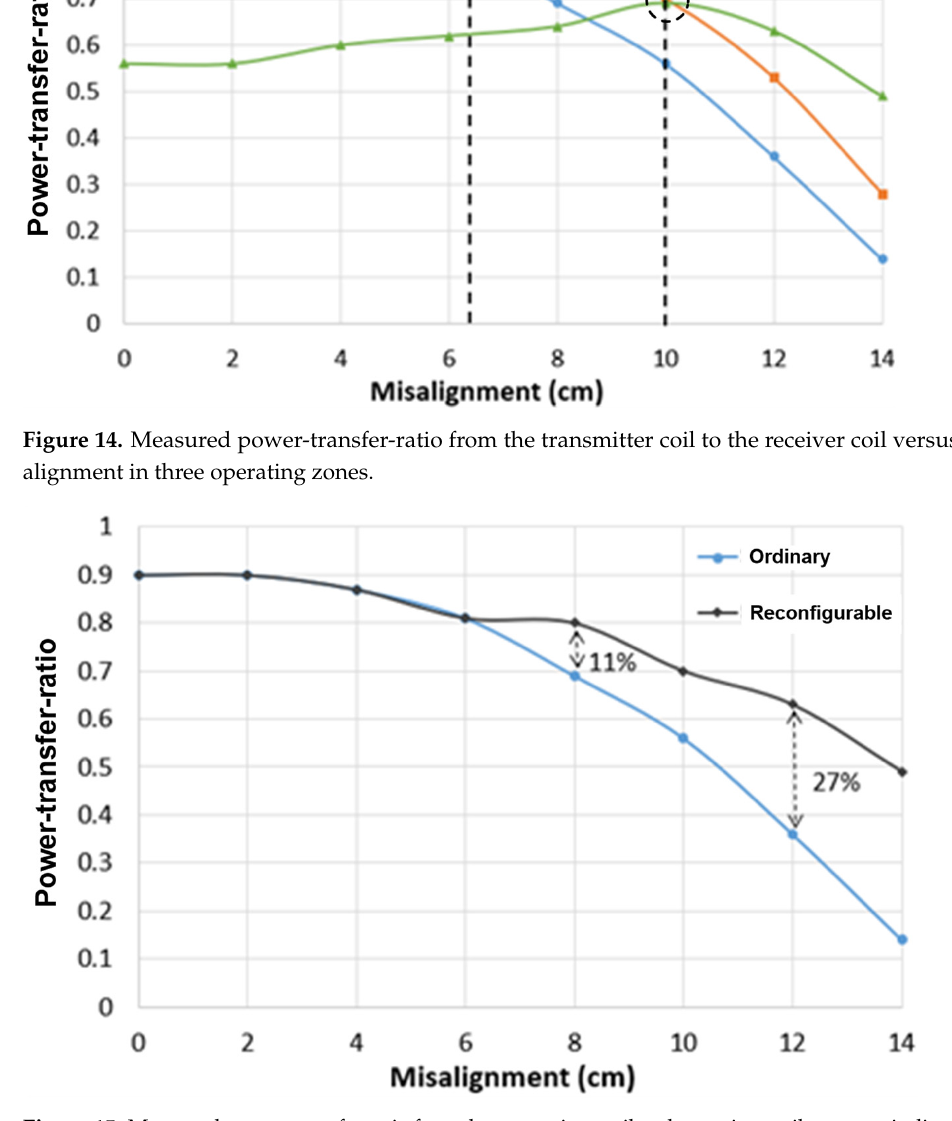
Figure 16. A 3D plot of measured power-transfer ratio from the transmitter coil to the receiver coil versus transmission distance and misalignment. 6. Conclusions With the use of a multi-tap transmitter coil and a zone impedance matching tech- nique, the power transfer capability of an inductive charging system is improved over a long distance. The proposed system adaptively performs impedance matching to cope with the change of transmission distance and misalignment. The input impedance of the transmitter coil is selected by switching different taps of the transmitter coil. The trans- mission power is significantly increased compared with the ordinary structure. The con- trol strategy uses the information from the transmitter to estimate the load position and select the proper turns of the transmitter coil. A proof-of-concept prototype was built to verify the proposed system and to evaluate the effectiveness of the control strategy. Ex- perimental results confirmed that the proposed system performs well in the case of trans- mission distance variation and misalignment tolerance. Increasing the number of taps in the transmitter coil will bring more significant improvement. However, designers should pay attention to the Q-factor of the coils, which significantly influences the system perfor- mance. A further increase in the operating frequency reduces the physical size of the